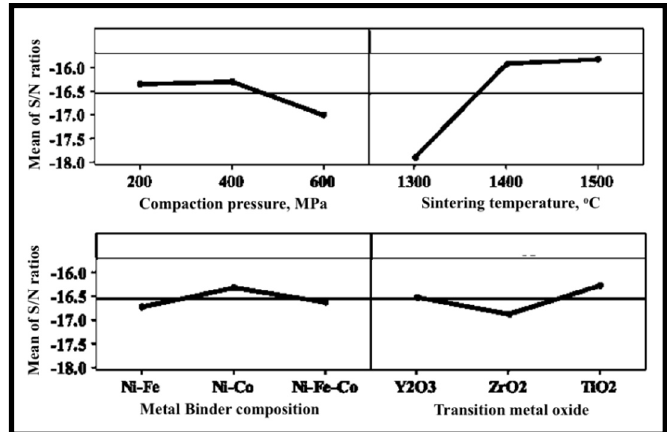
Figure 6. Mean of S/N ratios for electrical conductivity of samples versus levels of input parameters. Figure 6. Mean of S / N ratios for electrical conductivity of samples versus levels of input